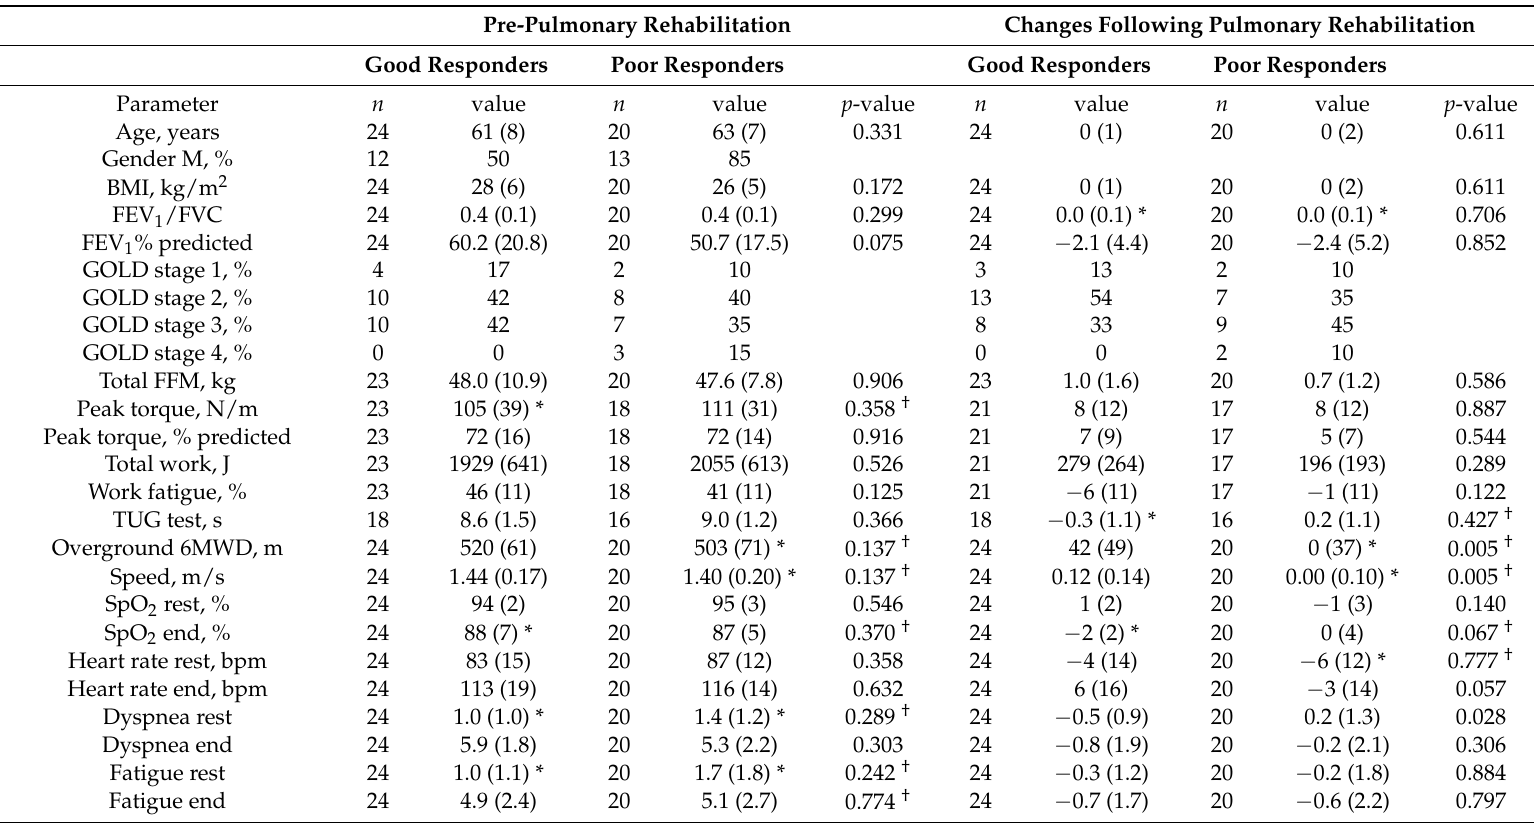
Table 4. Clinical outcomes of good and poor responders before and after pulmonary